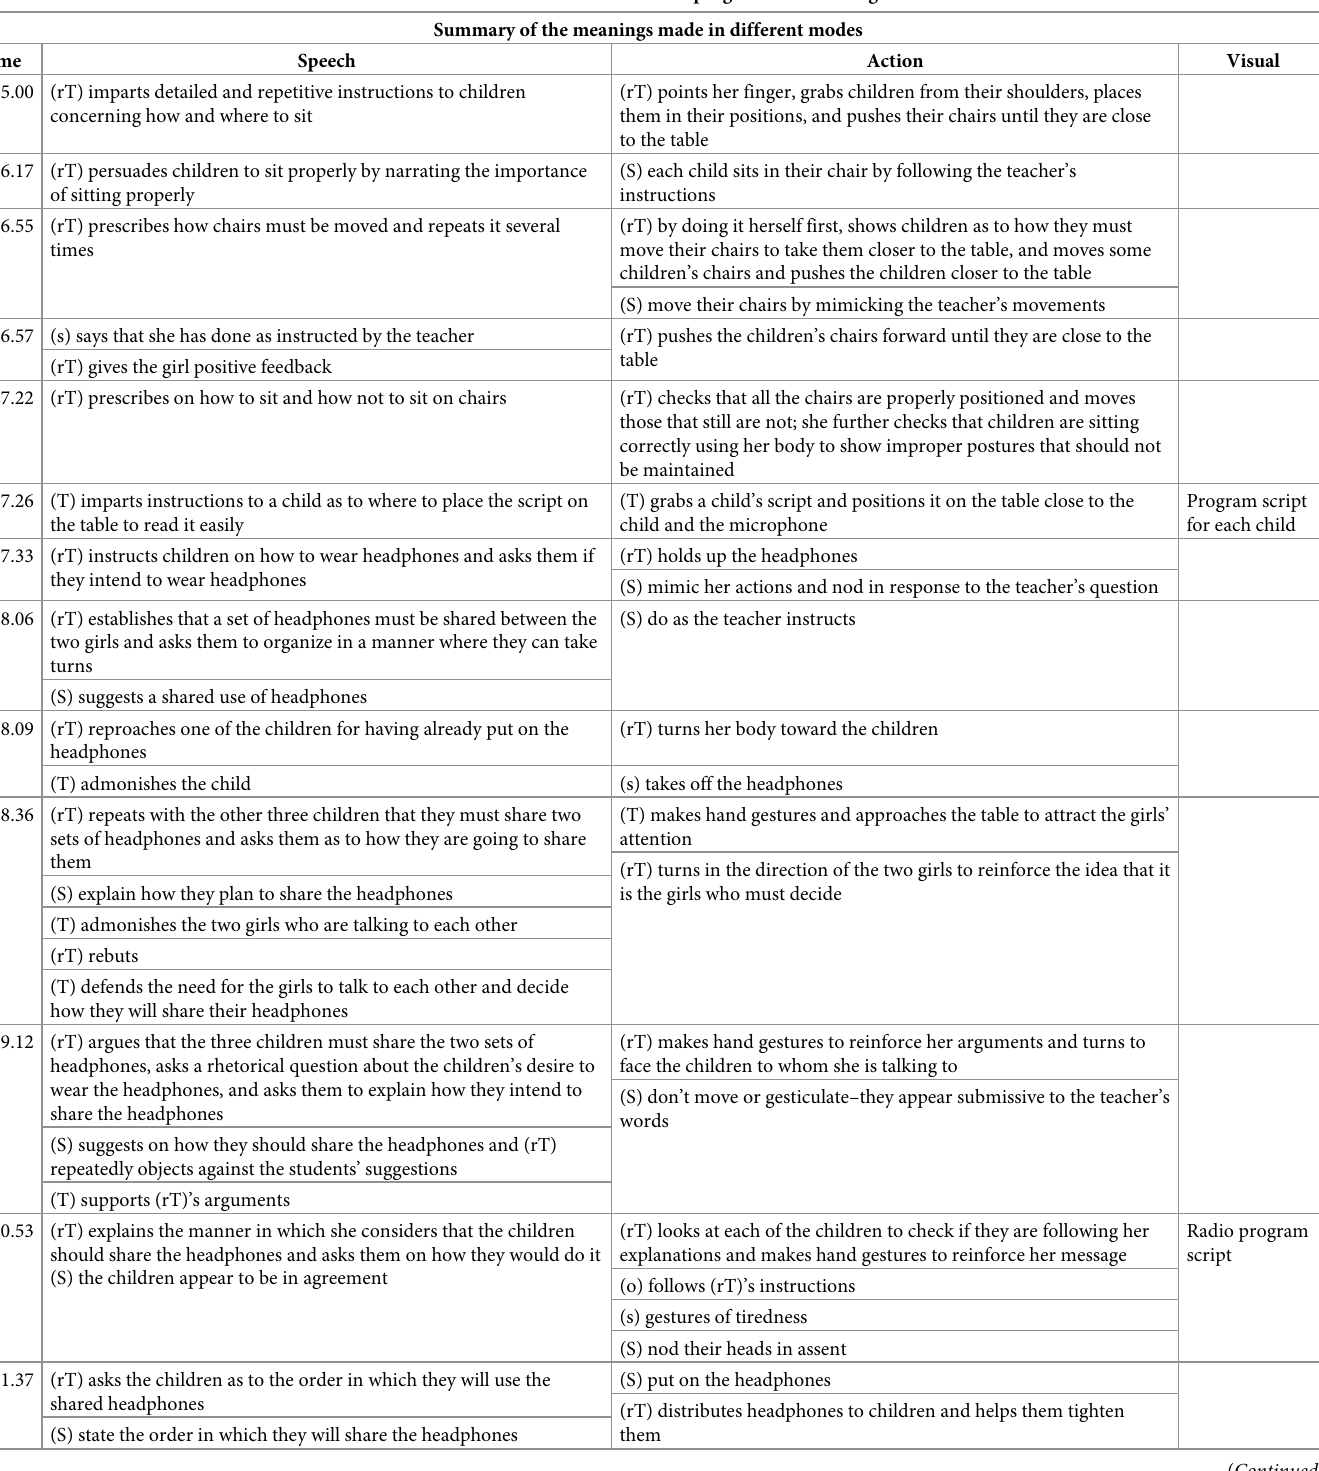
Table 3. The teacher’s and students’ communicative shifts between modes in the radio program broadcasting. Summary of the meanings made in different modes Time Speech Action